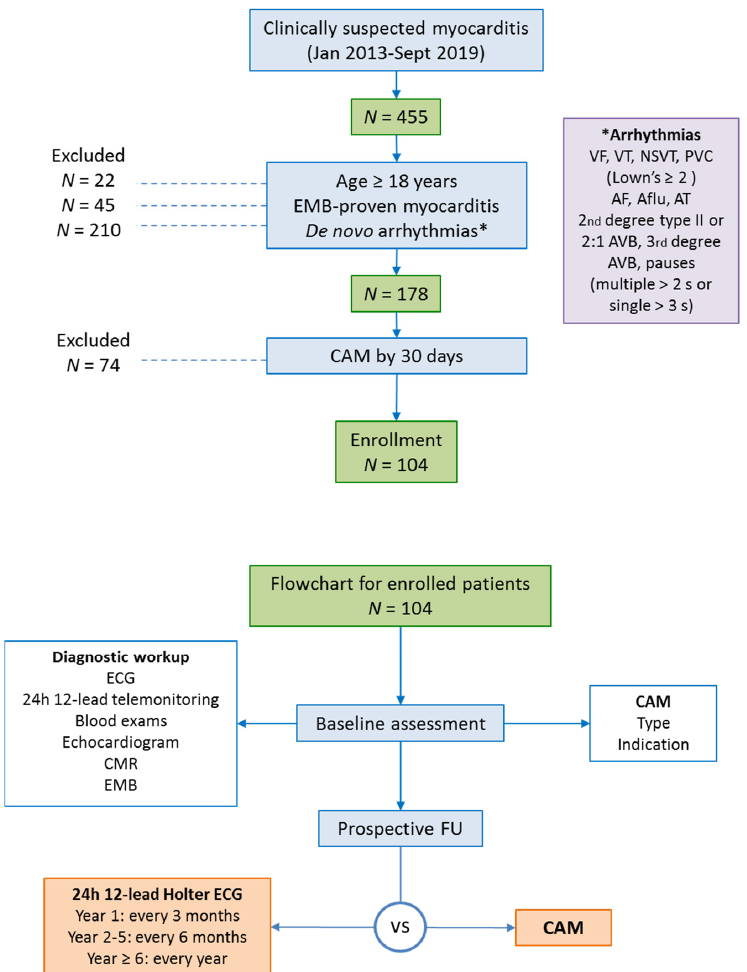
Figure 1. Study flowchart: study design with inclusion criteria is shown. AF = atrial fibrilla- tion; AFlu = atrial flutter; AT = atrial tachycardia; AVB = atrioventricular blocks; CAM = continu- ous arrhythmia monitoring; CMR = cardiac magnetic resonance; EMB = endomyocardial biopsy; FU = follow up; NSVT = nonsustained ventricular tachycardia; PVC = premature ventricular com- plexes; VA = ventricular arrhythmia; VF = ventricular fibrillation; VT = ventricular